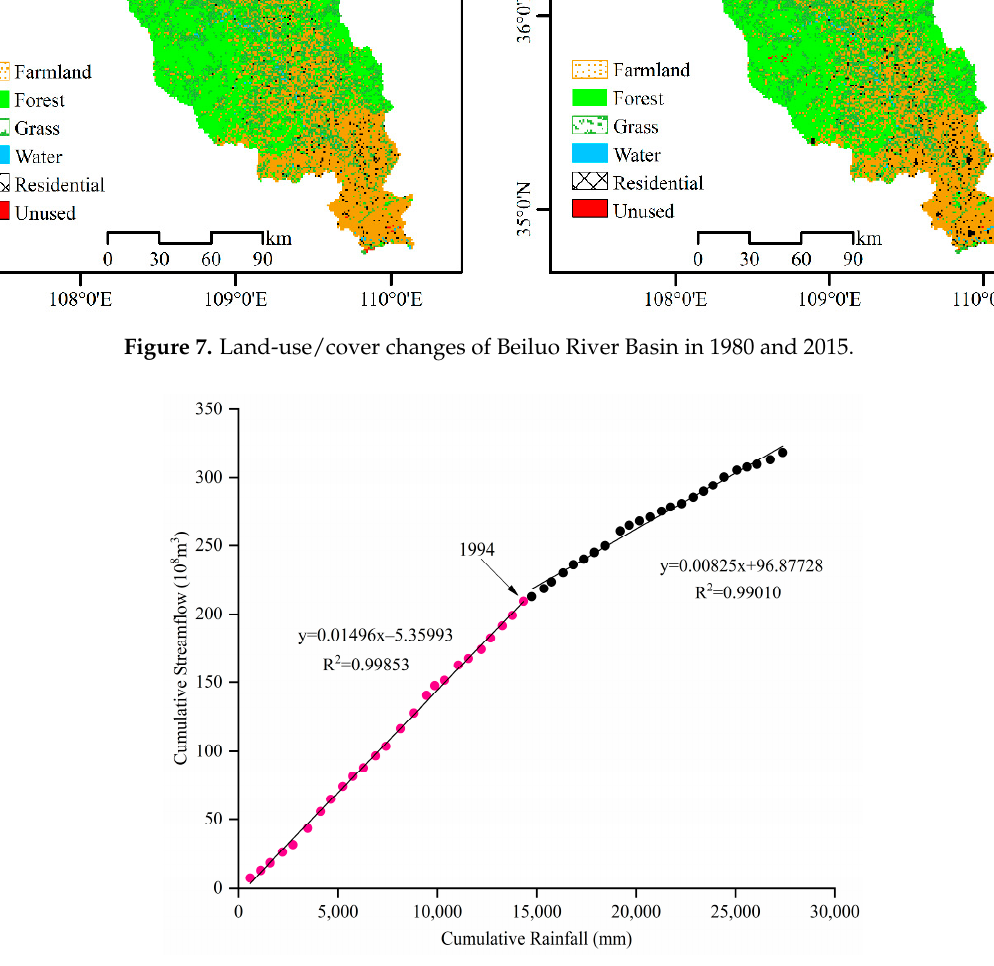
Figure 8. Double ‐ mass curve of precipitation–streamflow in the Beiluo River Basin. The straight lines are the regression lines for the cumulative data before and after the abrupt point year.